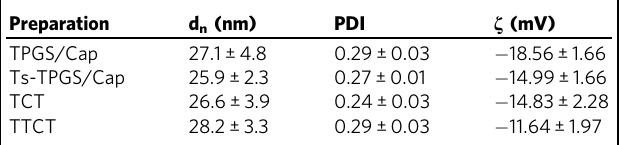
Table 1 Characterization of TPGS/Cap, Ts-TPGS/Cap, TCT, and